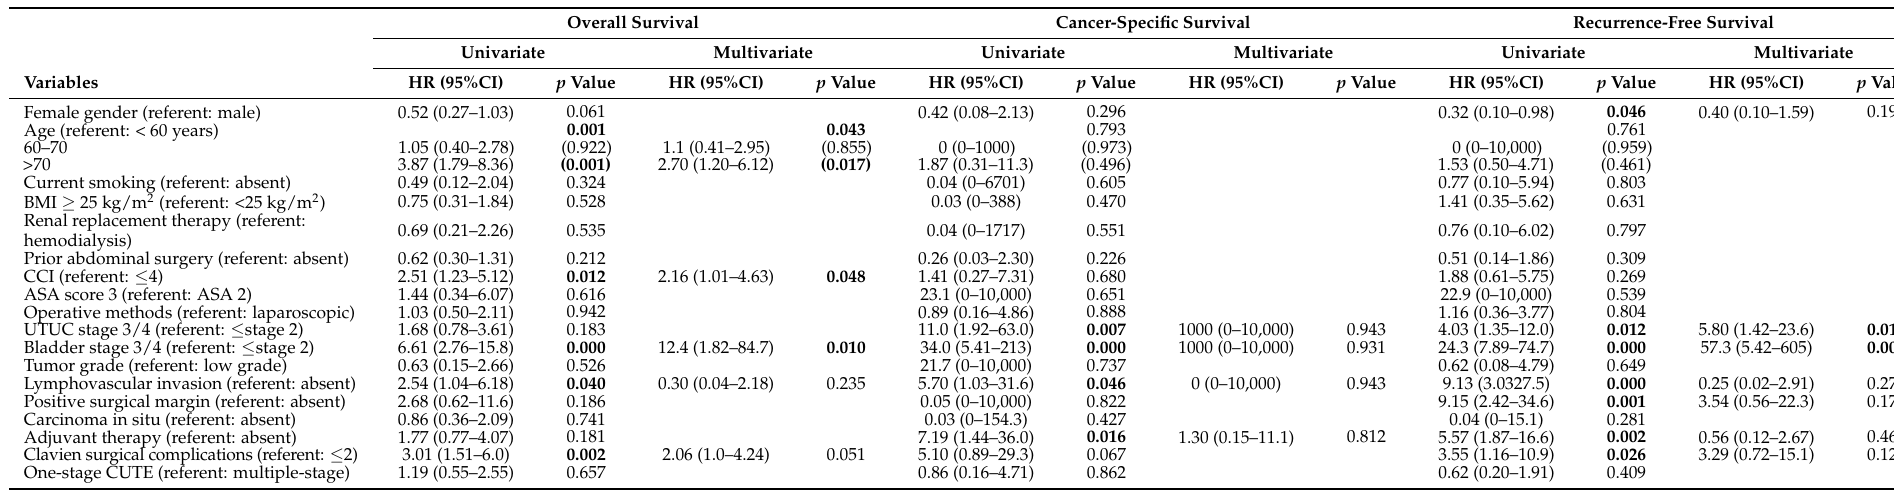
Table 5. Univariate and multivariate analysis of potential prognostic factors for overall, cancer-specific, and recurrence-free survival in the dialysis patients undergoing CUTE. Overall